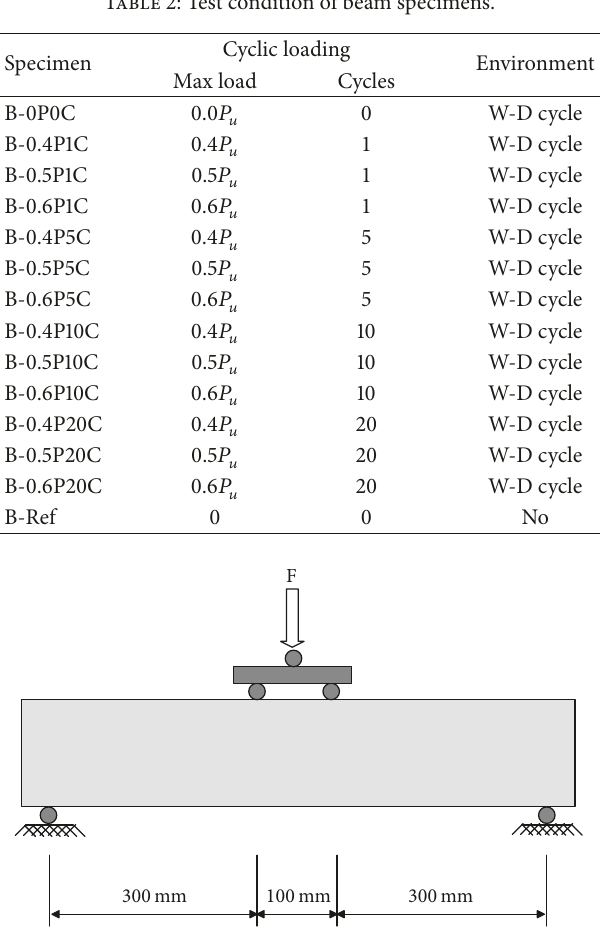
Figure 2: Schematic diagram of 4-point bending on beam speci- mens.